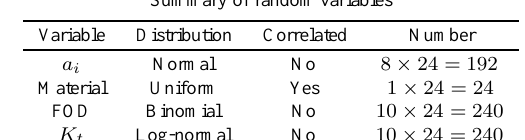
Table 1 Summary of random variables